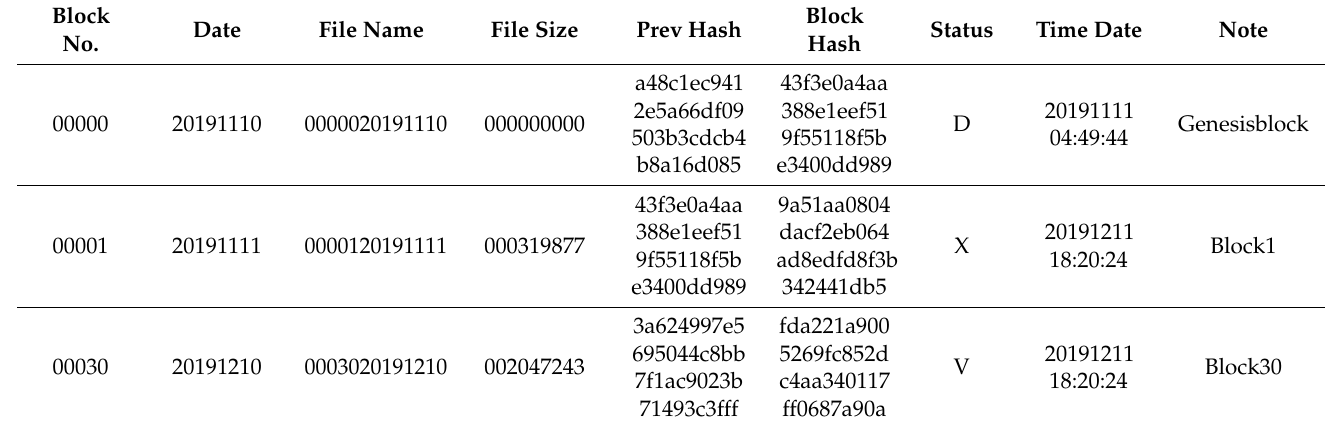
Table 9. Blockchain header file samples in tampered status.